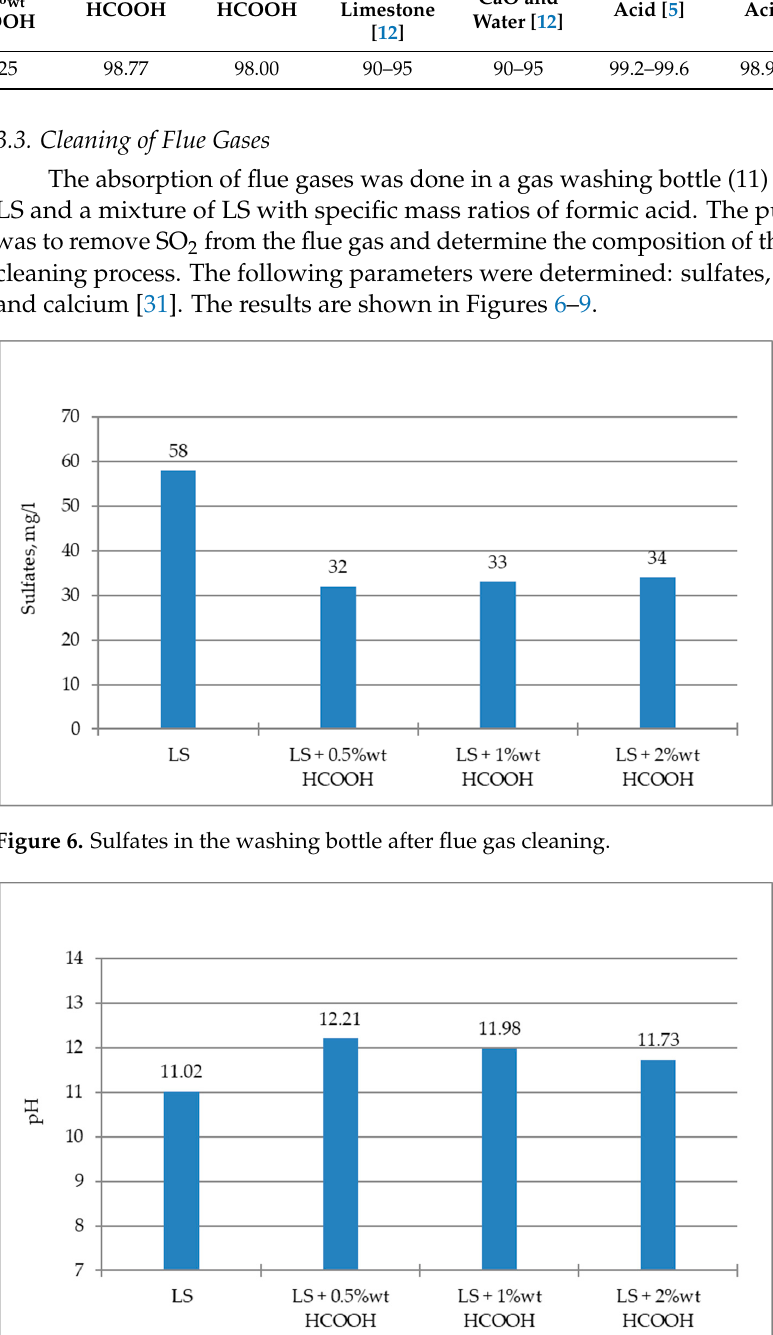
Table 4. Comparative data of SO 2 removal from flue gases by cleaning.